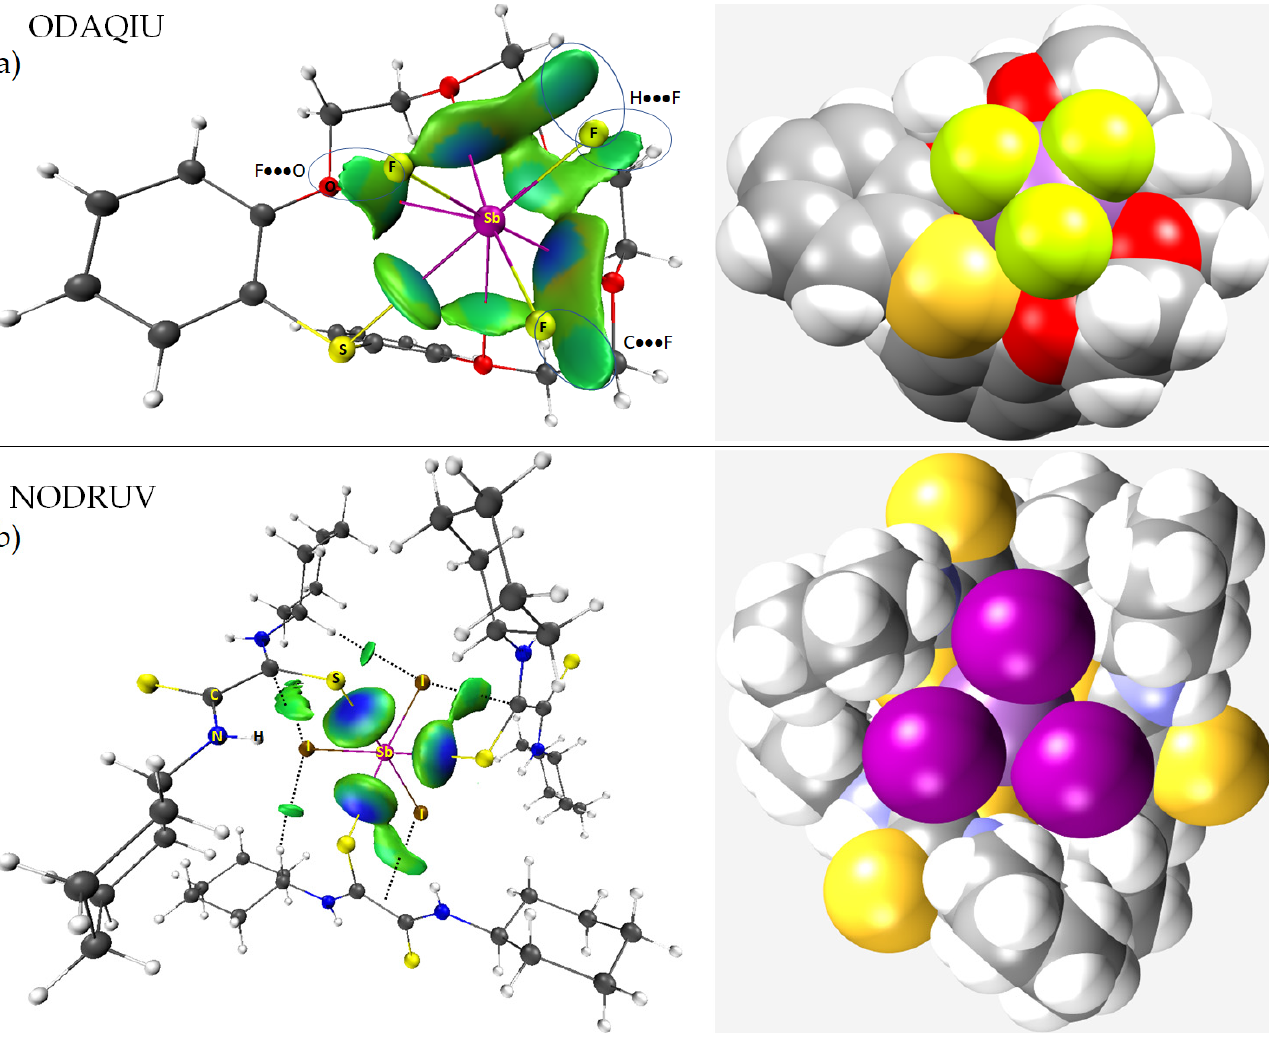
Figure 30. IGM- δ g based isosurface plots for ( a ) [1.5]dibenzothia-18-crown-6)SbF 3 [170], and ( b ) (HDTOA) 3 (SbI 3 ) 2 (HDTOA = N,N’ -dicyclohexyldithio-oxamide) [171]. Atom labeling is shown. Isosurfaces colored blue and green between the interacting molecules in the crystal signify strong and weak intermolecular interactions, respectively. Other intermolecular interactions (viz. hydrogen bonds, C···F, F···O and C···I bonds, etc.) are marked with dotted lines in ( b ) and circles in ( a ). The space-filling model is shown for each case.